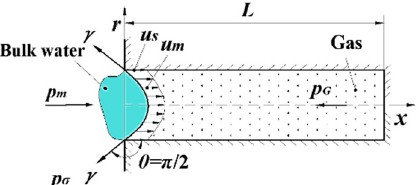
Figure 3. Flow patterns of water in hydrophobic silica nanochannels.